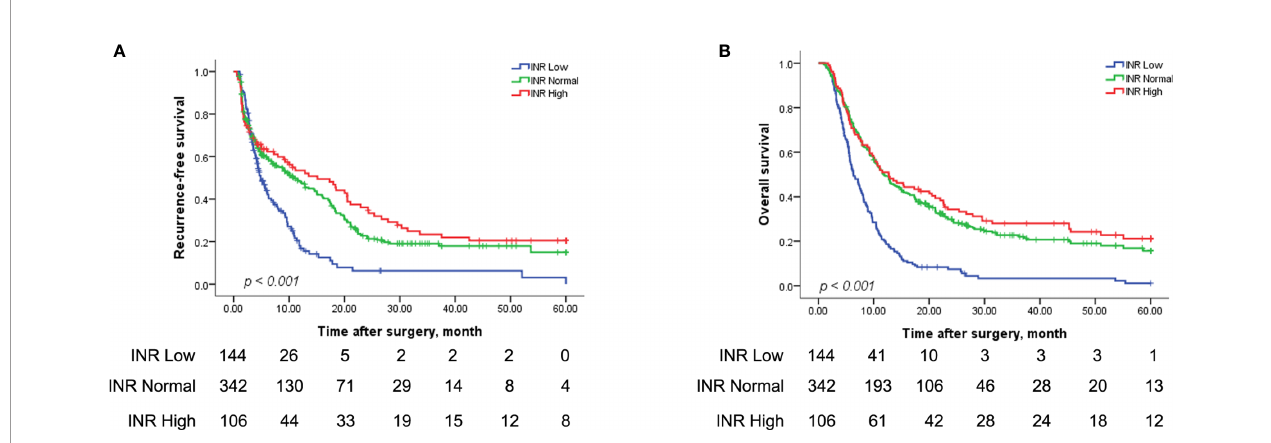
FIGURE 3 | Kaplan-Meier analysis for the RFS and OS rates in HCC patients with types I/II PVTT after R0 LR among the Low, Normal, and High INR groups. RFS for patients among the Low, Normal, and High INR groups (144 patients vs 342 patients vs 106 patients) after R0 LR (A) (P < 0.001); OS for patients among the Low, Normal, and High INR groups (144 patients vs 342 patients vs 106 patients) after R0 LR (B) (P < 0.001). INR, international normalized